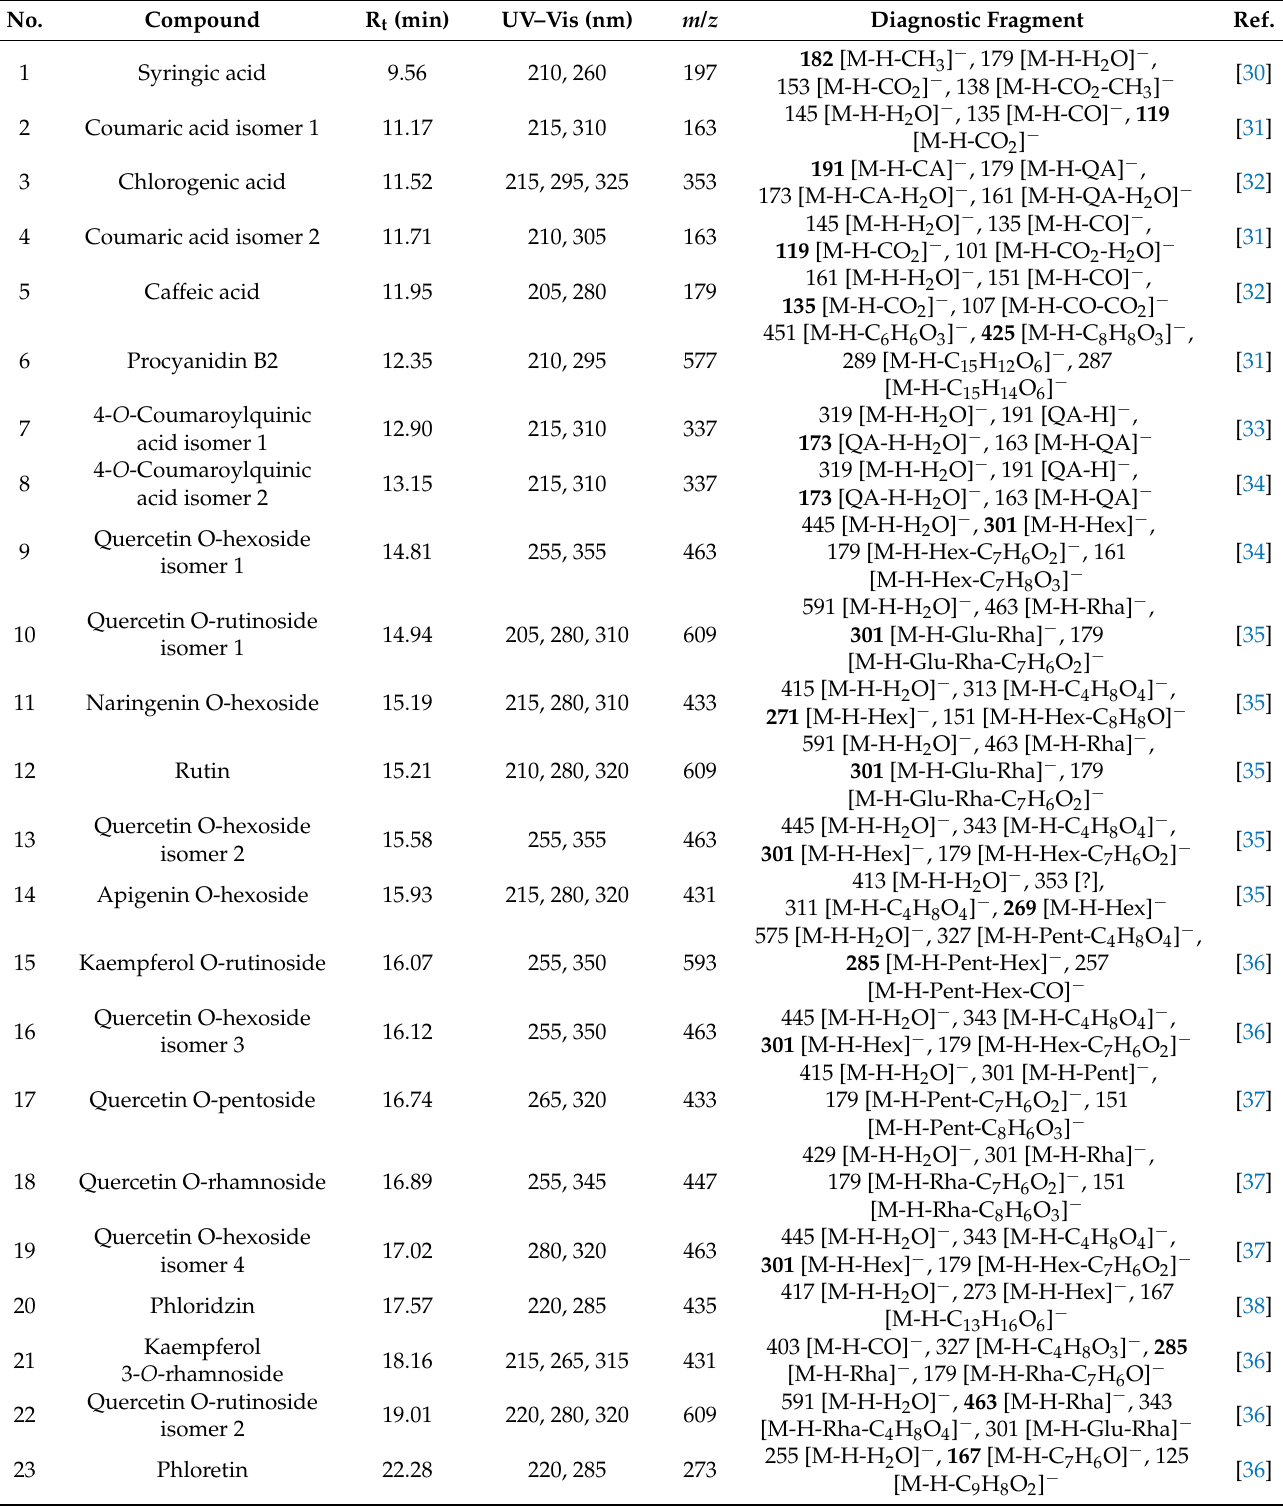
Table 3. Polyphenolic composition of OAALE extracts determined by HPLC-HESI–MS/MS